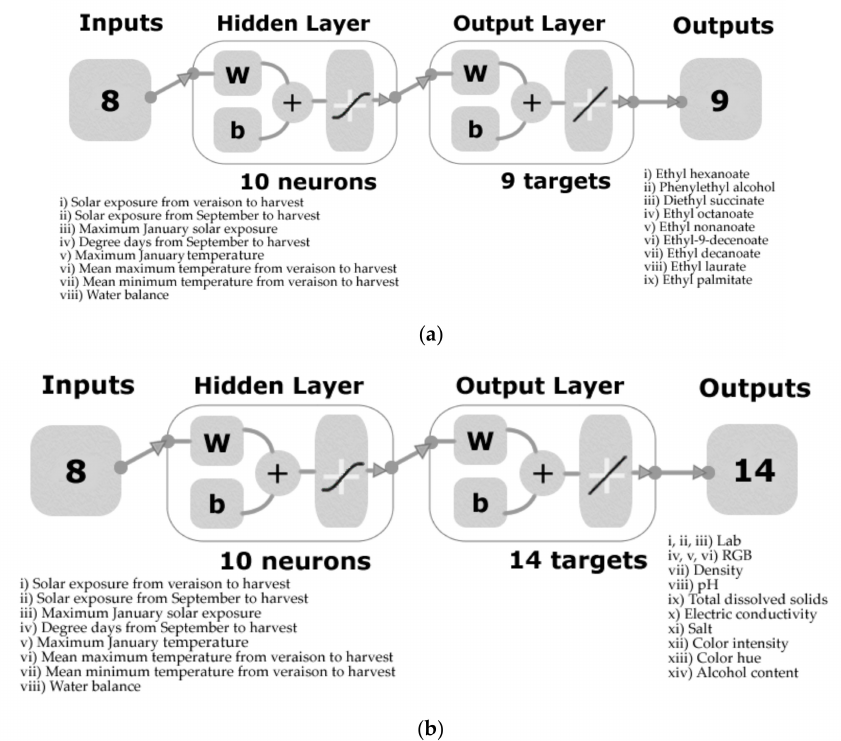
Figure 2. Artificial neural network model diagrams showing the inputs and target / outputs of ( a ) Model 1 to predict the aroma profile based on the peak area of volatile aromatic compounds, and ( b ) the physicochemical data of Pinot noir wines.